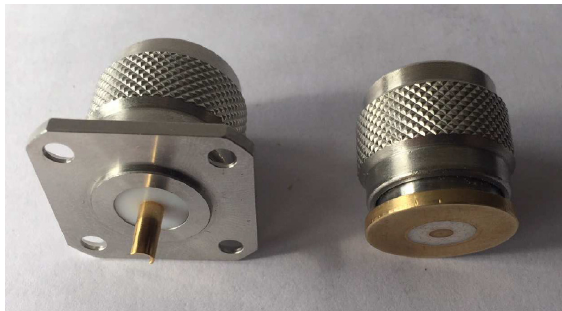
Figure 3. N connecter (left) and the derived open‐ended coaxial probe